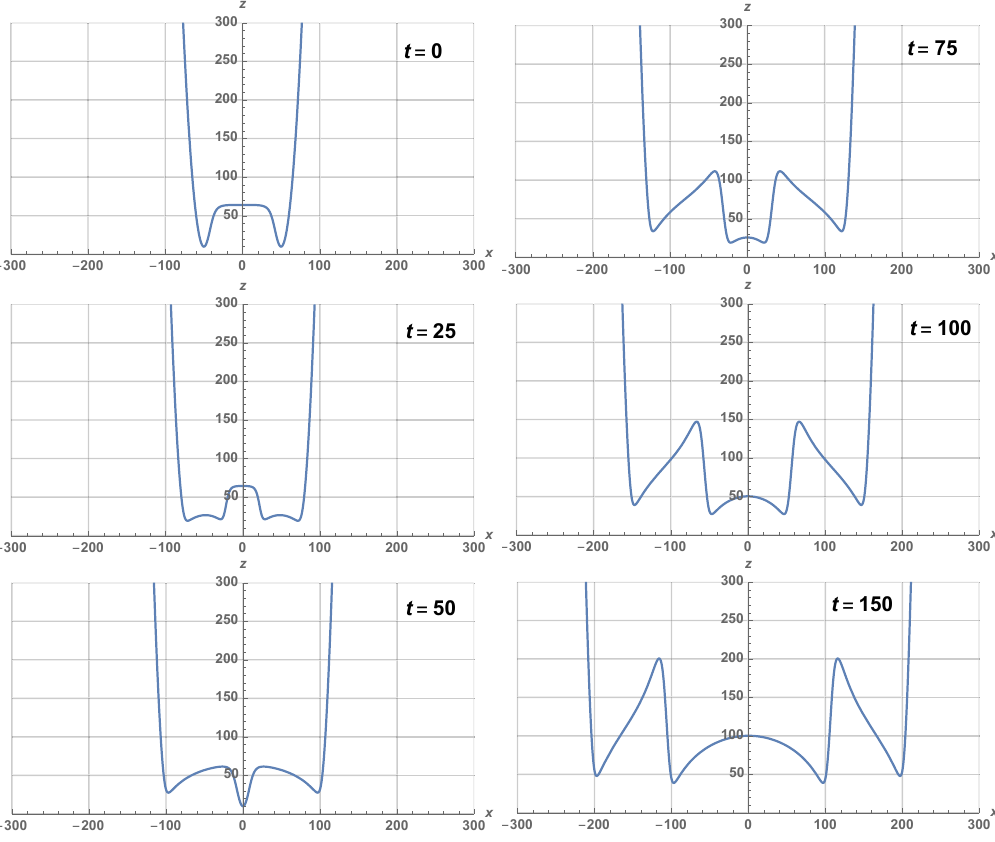
Figure 25 . Boundary surface in double joining quench on different time slices with sufficiently small a . (Here, we have b = 50 and a = 5.) At t = 0, the boundary has two sharp angles localized at x = b , and then both of them moves to x direction. At large t , the boundary surface can be ± ± b ) 2 and two sharp angles roughly regarded as two vertical lines x = b , a semicircle x 2 + z 2 = ( t − ± at each side between them. The boundary is falling towards + z direction as a